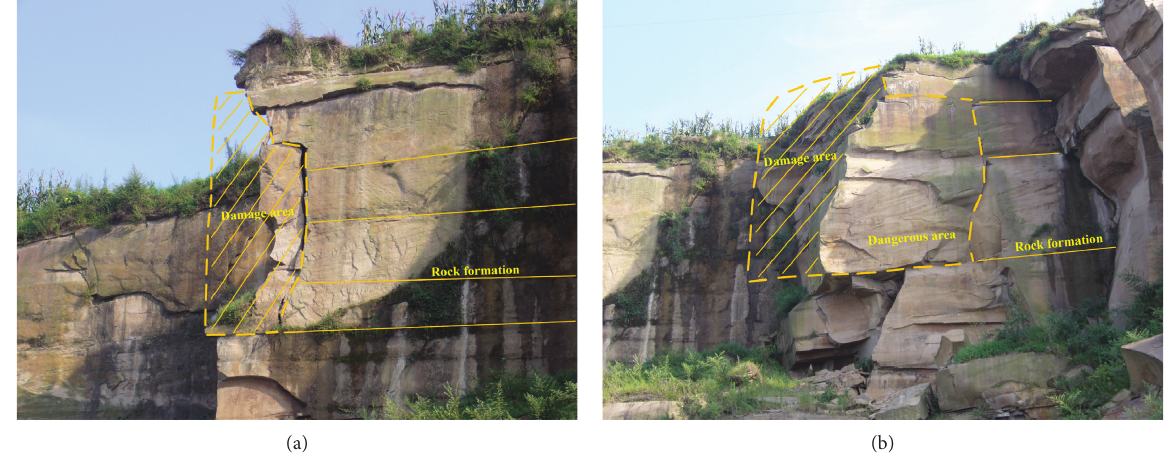
Figure 19: On-site destruction of #3 and #4 dangerous rock slopes. (a) #3. (b)